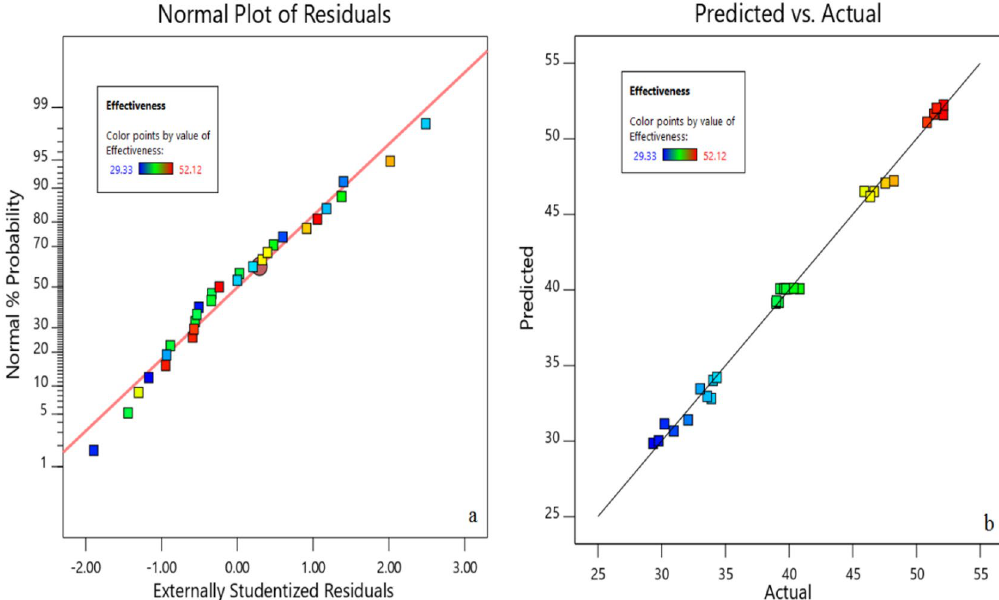
Figure 11. ( a ) Residual normal dispersion diagram for CFCT effectiveness ( b ) the comparison of the acquired experimental values with the predicted effectiveness values of TiO 2 nanofluid.